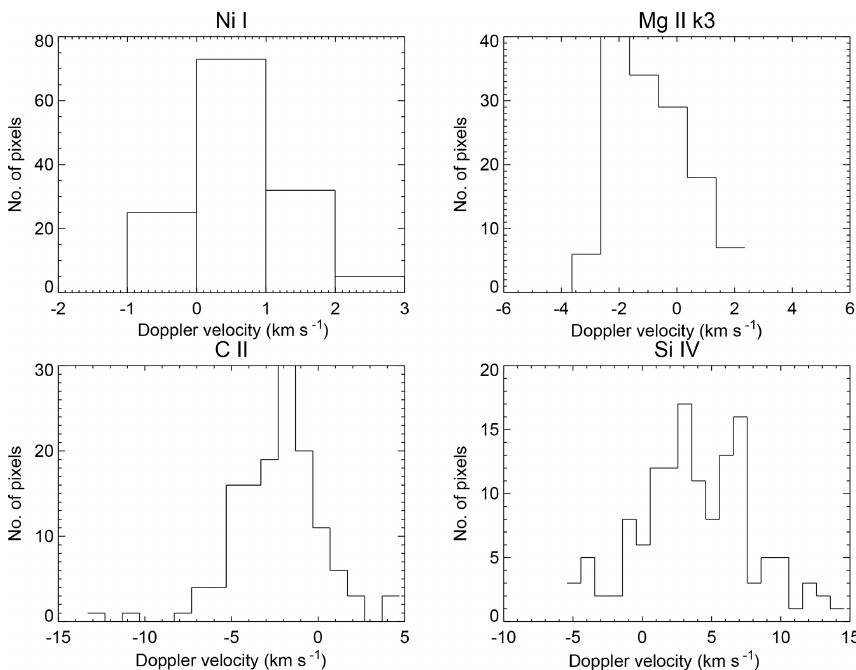
Figure 7. The velocity distributions for different spectral lines corresponding to different temperatures at box